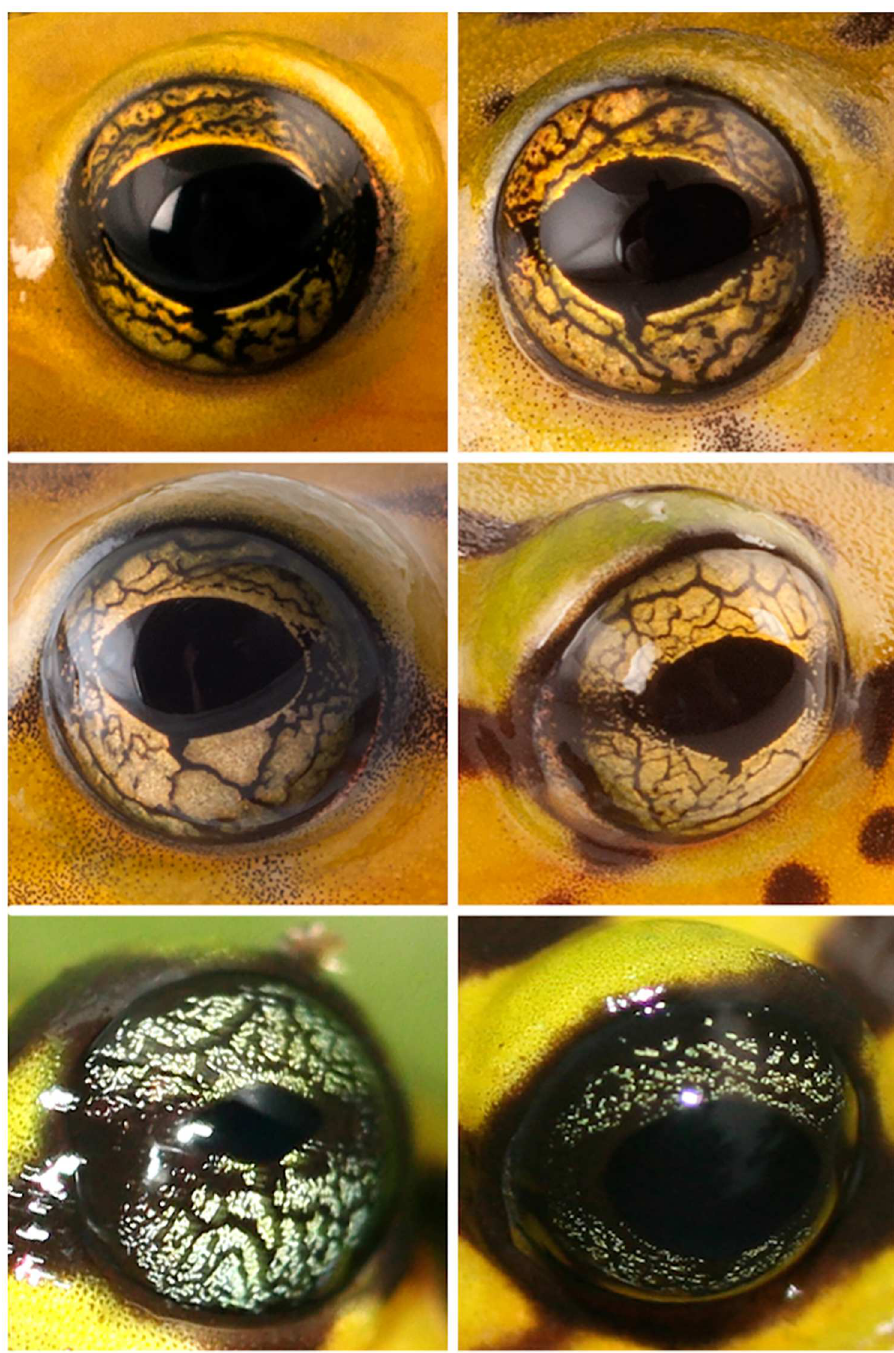
Fig 2. Variation in iris coloration in life of Pristimantis ornatissimus sensu stricto and P . ecuadorensis sp. nov. First (CJ 4092, CJ 4085) and second (no voucher, CJ 4087) rows show iris color of Pristimantis ornatissmus sensu stricto. Bottom row illustratescolorationof P . ecuadorensis sp. nov (no voucher, CJ 4082).